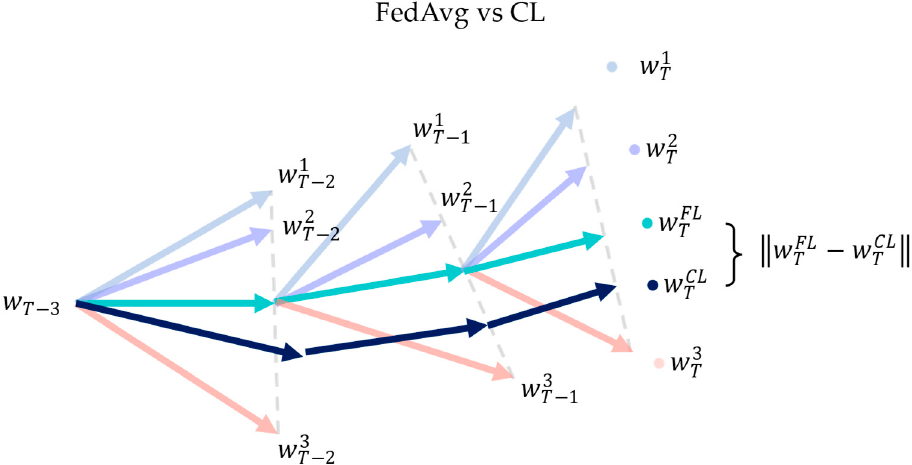
Figure 1. Weight divergence between 𝒘 (cid:3047)(cid:3007)(cid:3013) and 𝒘 (cid:3047)(cid:3004)(cid:3013) is inevitable even if both models have the same initialization weights.